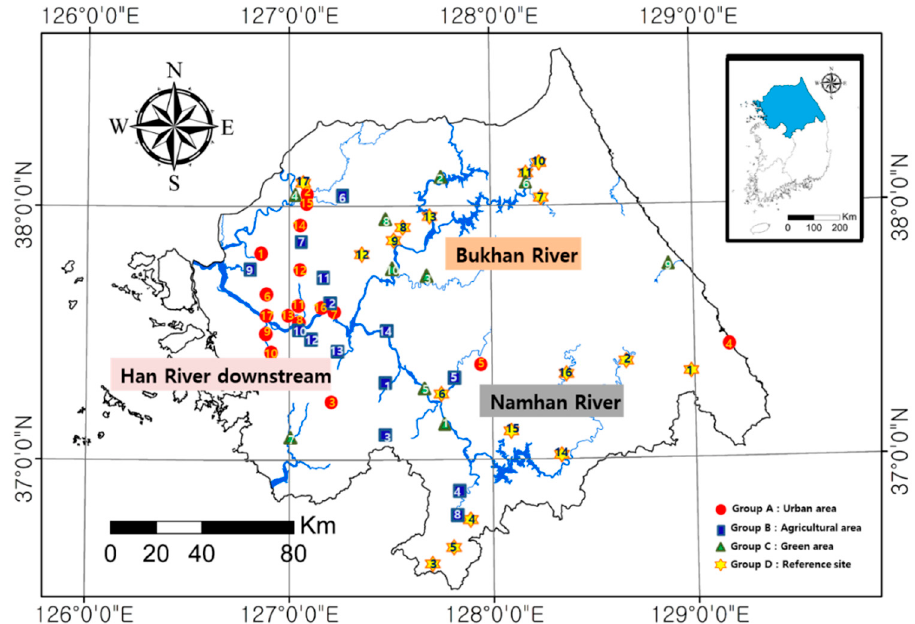
Figure 1. The Han River is a major river in South Korea, formed by the confluence of the two major branches of the river, the Namhan River and the Bukhan River. Fifty-eight monitoring sites (four groups) along the Han River in South Korea.